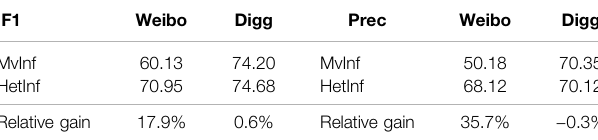
TABLE 3 | Relative gain in terms of F1 and Prec. against the best baseline